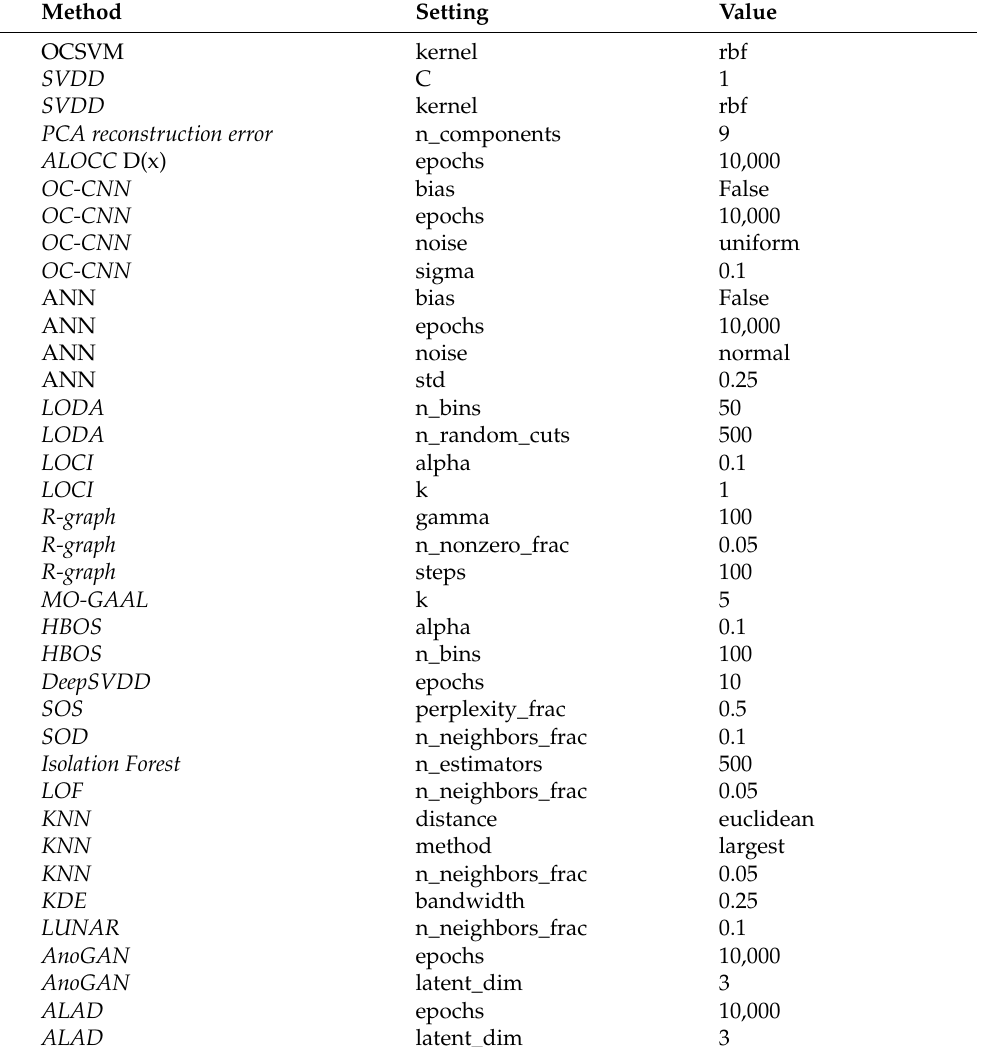
Table A3. Settings used for the experiment as described in Appendix